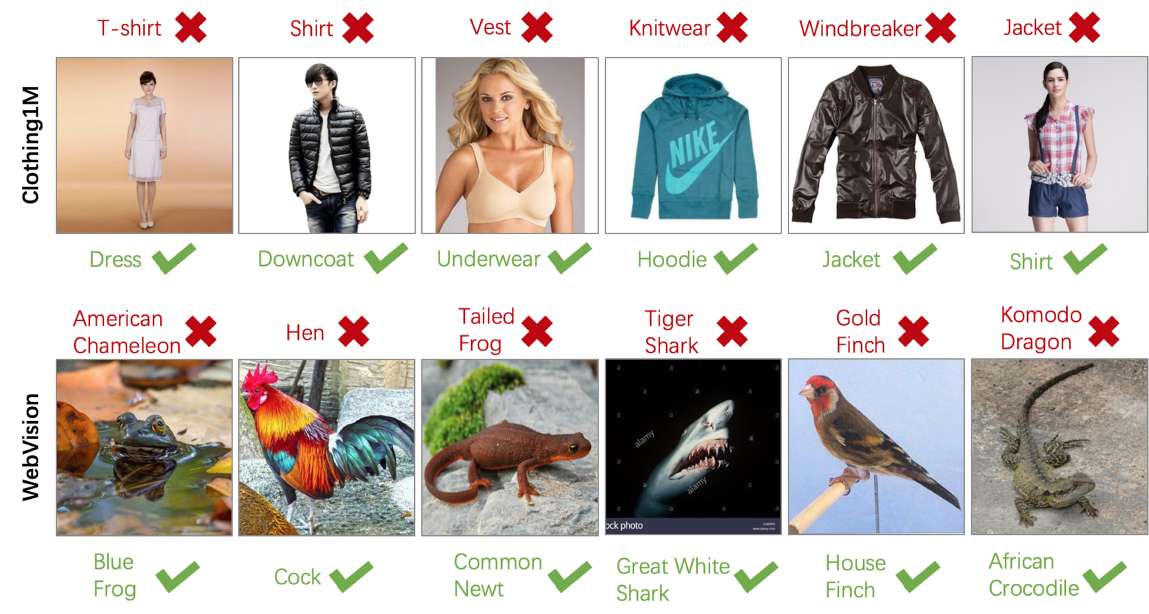
Figure 3. Examples of rectified labels by FGCM in Clothing1M and WebVision datasets. Red labels denote original annotations which are obviously wrong. Green labels denote rectified labels produced by FGCM which are obviously